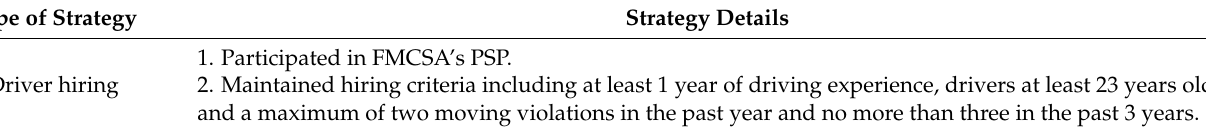
Table 6. Fleet D’s safety improvement